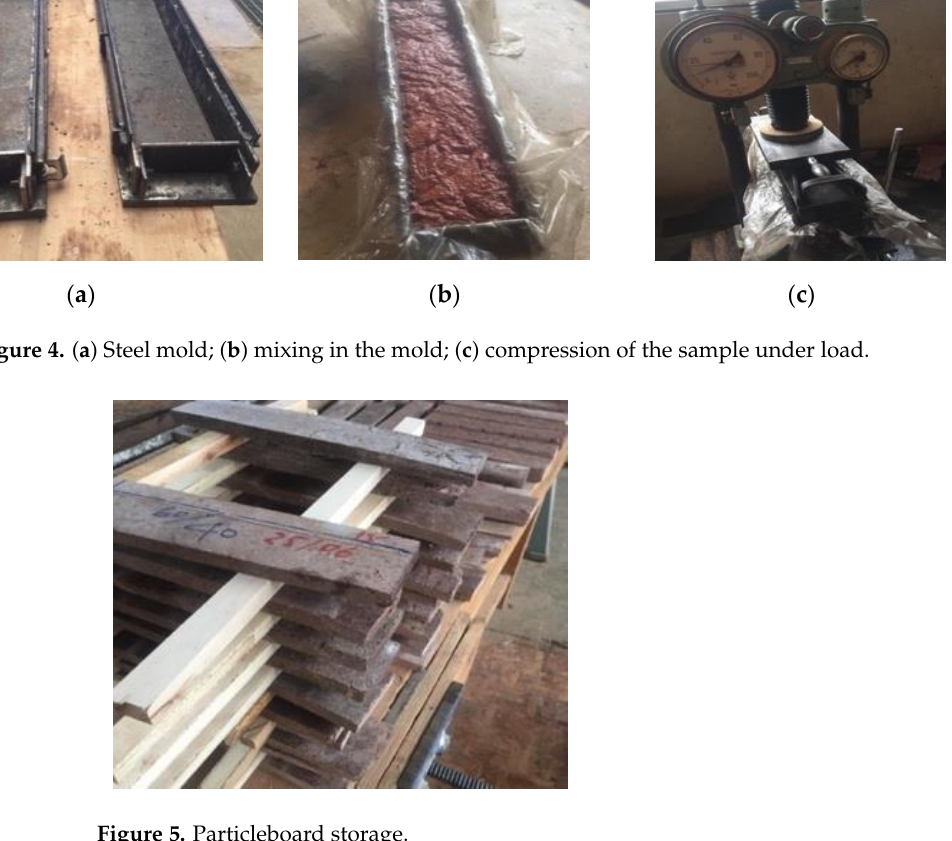
Figure 4. ( a ) Steel mold; ( b ) mixing in the mold; ( c ) compression of the sample under load .